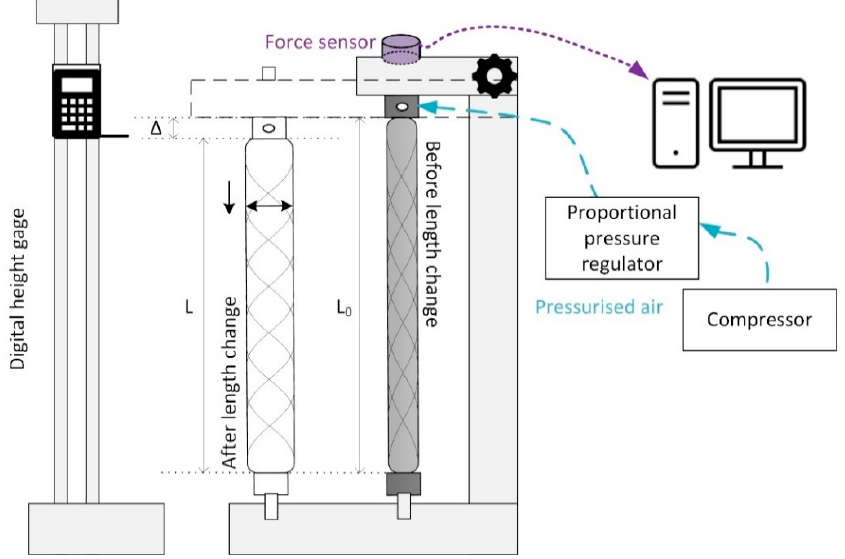
Figure 3. Schematic of the test stand used for measuring the characteristics of the DMSP-5